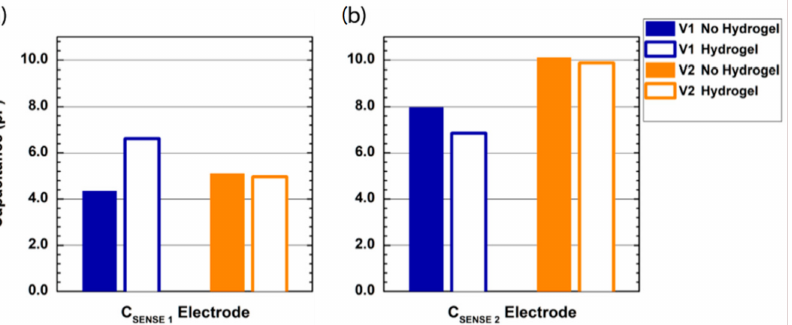
Figure 4. Results of the measurement of the known capacitance of a passive oscilloscope probe (12 pF) on the two sensing nodes (( a )—C SENSE 1 , ( b )—C SENSE 2 ) of the resonant network on the probe V1 (blue histograms) and V2 (orange histograms). Full/hollow bars report results without/with a hydrogel layer on the capacitive sensor surface. The two graphs share the y-axis label and the